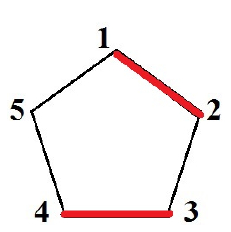
Figure 7. C 5 : by “rotating” the packing set, one can see that each vertex is not included in some packing. So, x 1 = . . . = x 5 = 0, which contradicts condition x 1 + . . . + x 5 = 2.